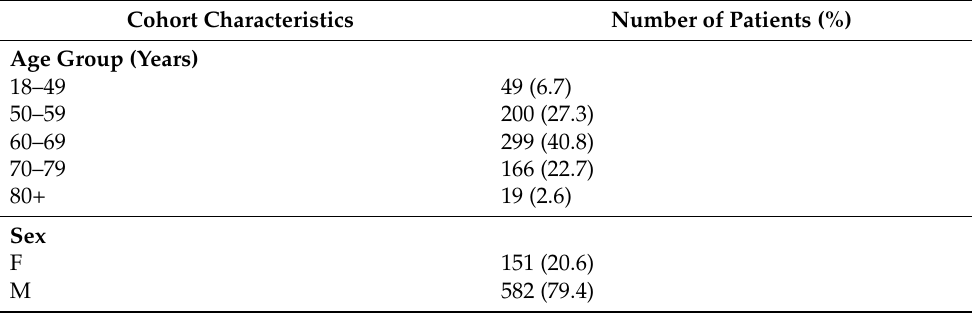
Table 1. Patient, disease, diagnosing physician, and healthcare system characteristics of Ontario patients undergoing trimodal treatment for esophageal cancer between 2013 and